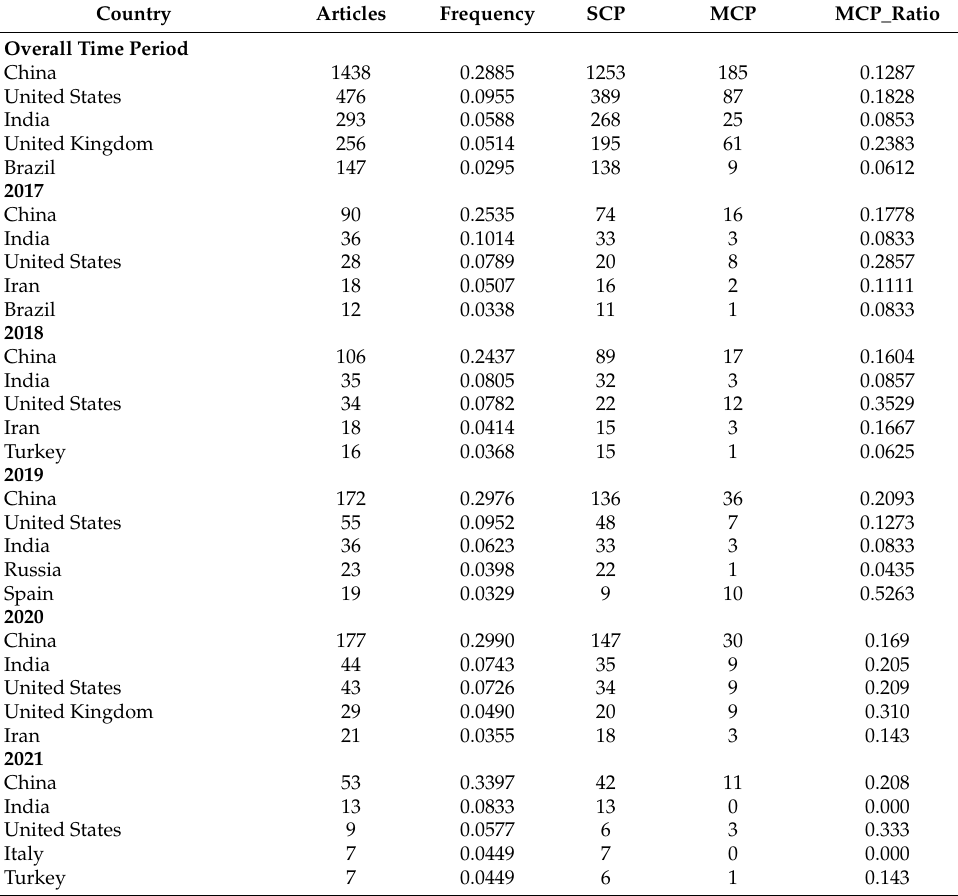
Table 8. Corresponding authors’ countries, overall period, and per